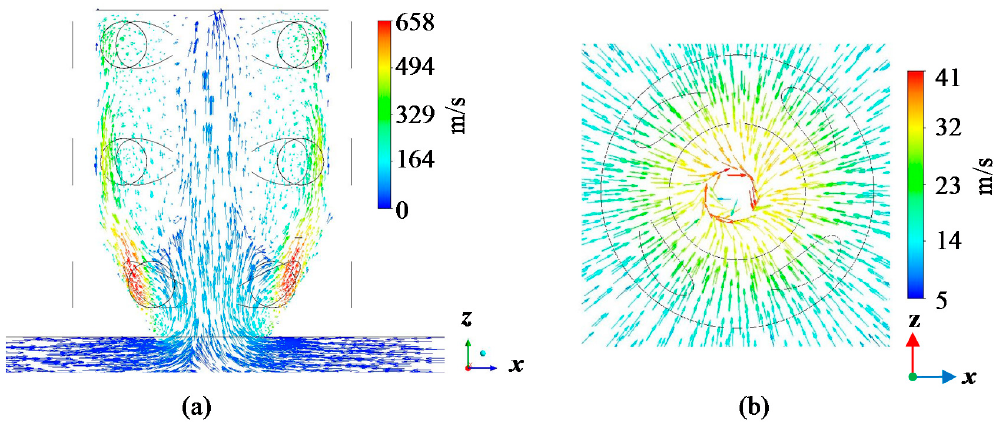
Figure 5. Numerical results of ( a ) velocity contours (section view) and ( b ) velocity profile (top section view of nozzle at 2 mm above surface of machining material) for gas inlet pressure of 300 kPa and gas outlet pressure of 30 kPa. Appl. Sci. 2017 , 7 , 502